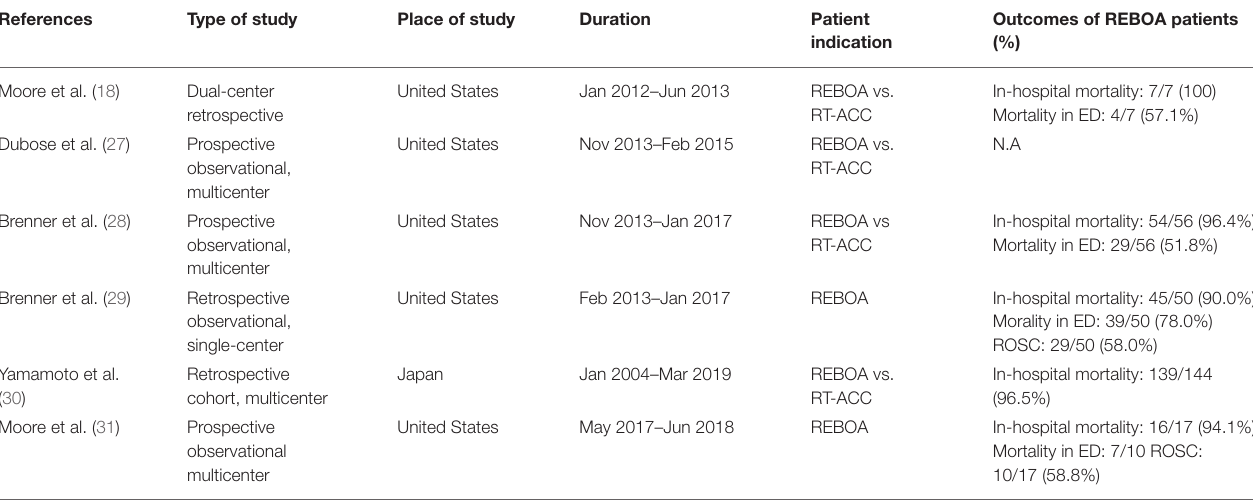
TABLE 1 | Summary of previous studies of mortality of REBOA for